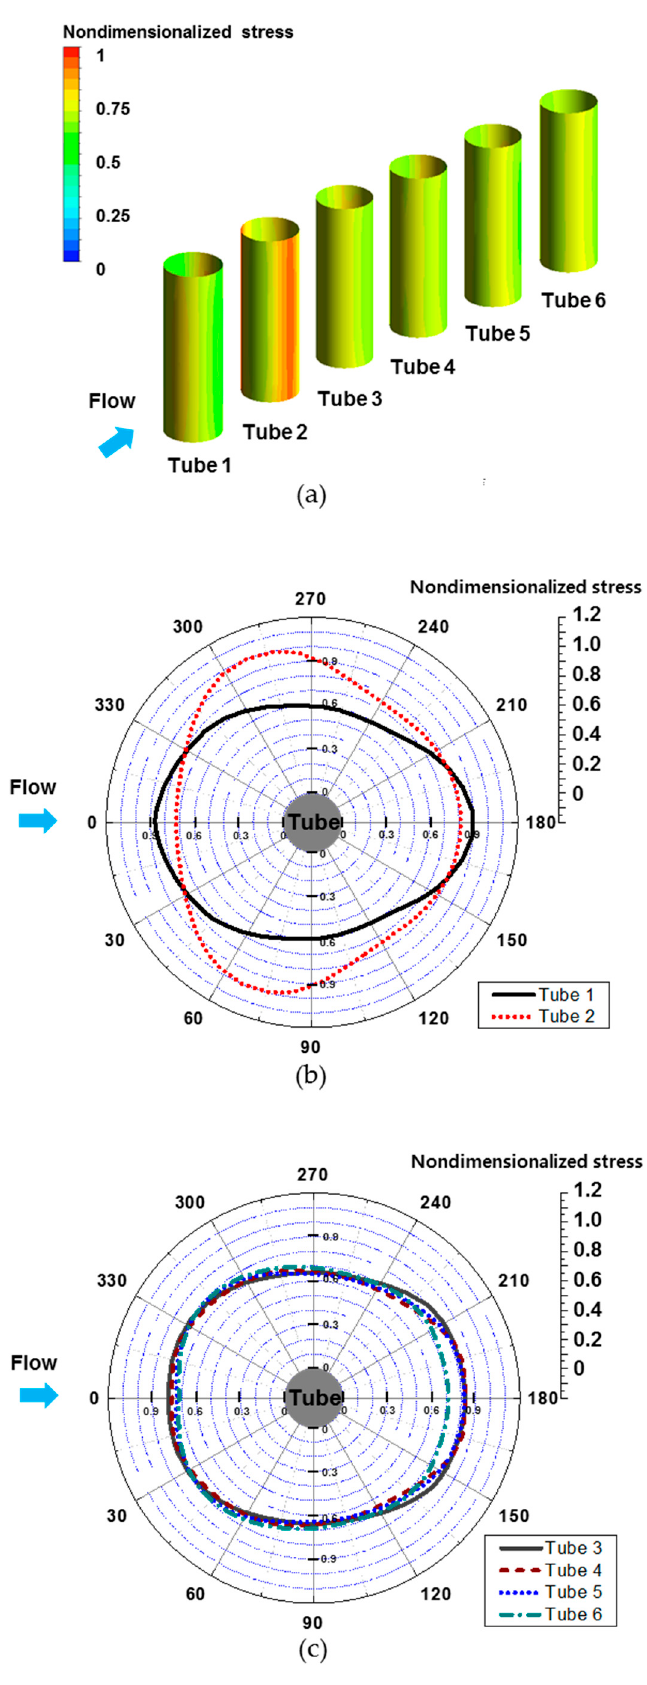
Figure 9. ( a ) Stress distribution of tube bundles for Re = 30,000, Vertically averaged stress distribution; ( b ) Tubes 1 and 2; ( c ) Tubes 3–6.